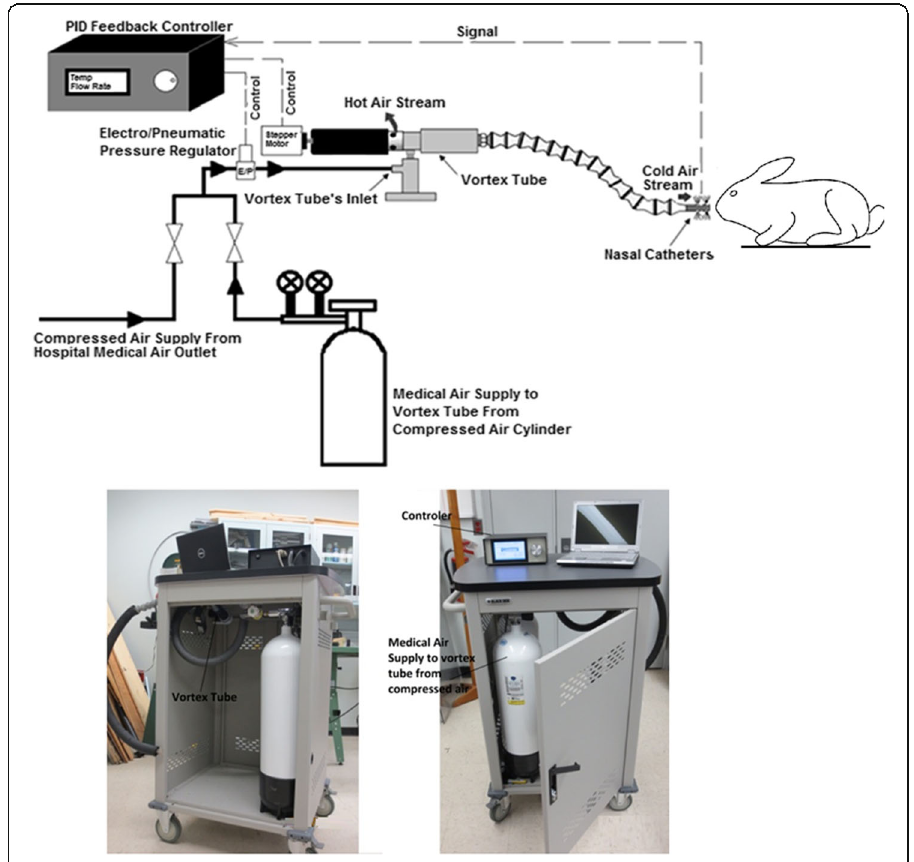
Fig. 1 Schematic representation of the cooling circuit used for nasopharyngeal brain